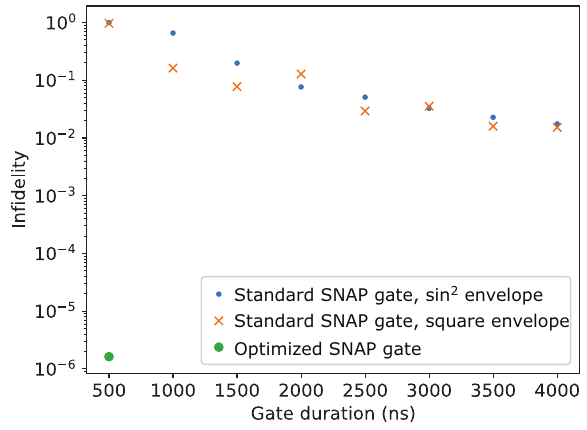
FIG. 7. Simulated comparison of the infidelity of state S ( (cid:2) θ 1 ) | α 1 (cid:4) created with standard or optimized SNAP gates of different lengths. Here α 1 = 1.39 and θ 1 = ( 2.049, − 0.654, 1.130, − 1.106, 0, 0, . . .) are the parameters of the first displace- ment and SNAP gates in the sequence making Fock state | 2 (cid:4) . This simulation is performed without taking loss into